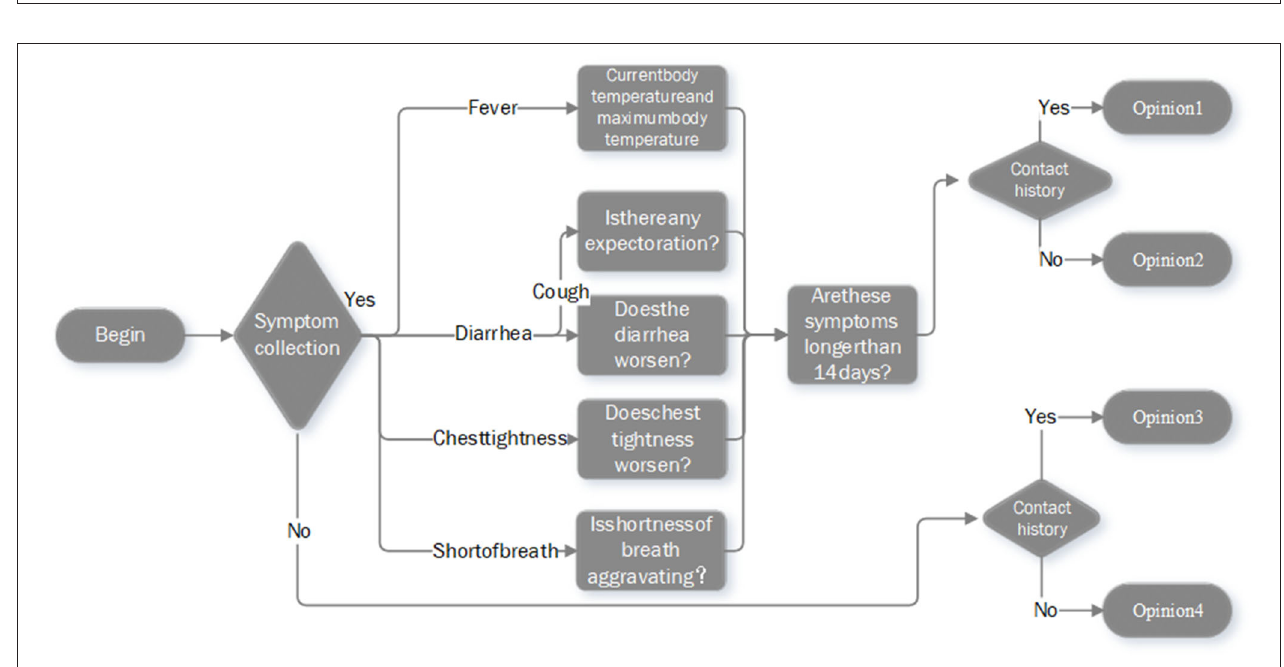
FIGURE 5 | Operation procedure of the intelligent response